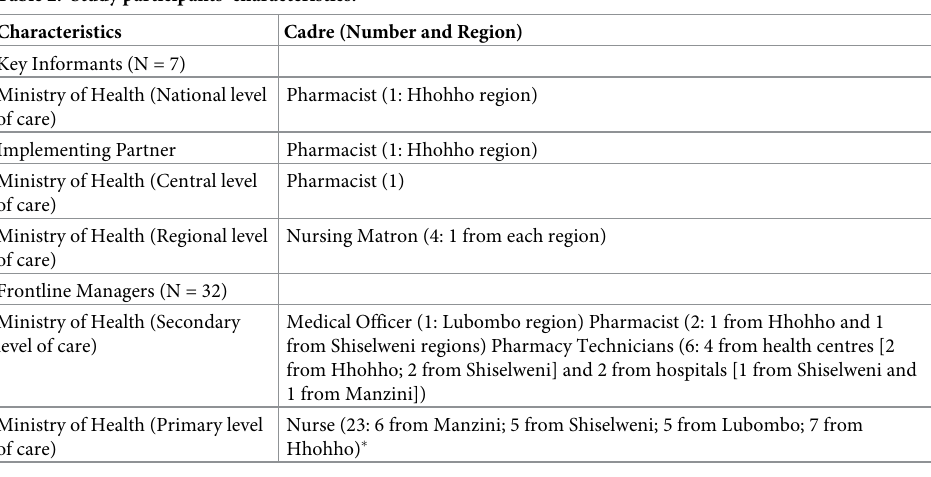
Table 2. Study participants’